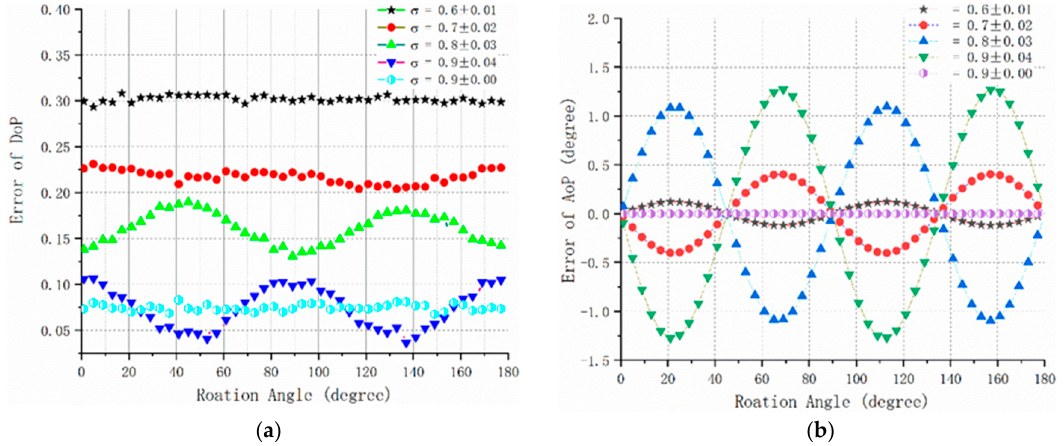
Figure 3. Effect of extinction ratio coefficient on the sensor simulation diagram. ( a ) degree of Figure 3. E ff ect of extinction ratio coe ffi cient on the sensor simulation diagram. ( a ) degree of polarization polarization (DOP) error; ( b ) azimuth of polarization (AOP) error. (DOP) error; ( b ) azimuth of polarization (AOP)